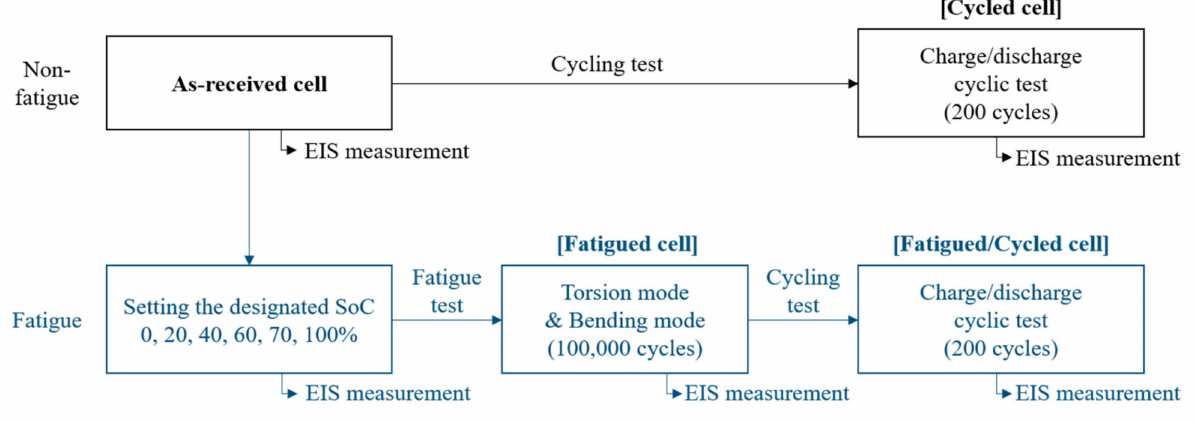
Figure 1. The experimental flow chart of this